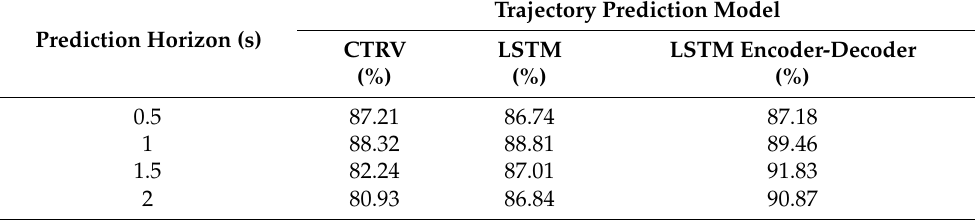
Table 4. Trajectory prediction